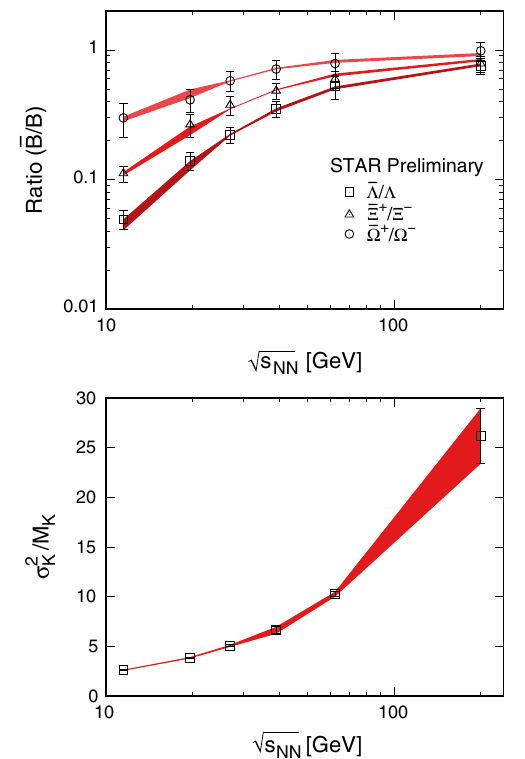
Fig. 1 Upper panel: Ratio ¯ B / B of strange anti-baryon over baryon √ s NN . The yields for (cid:9) , (cid:6) − and (cid:10) − as a function of the beam energy published and preliminary STAR data (symbols) are taken from [17– 19], respectively. The colored bands show the fit results for ¯ B / B within the employed HRG model for the freeze-out conditions determined in this work. Lower panel: Lowest-order net-kaon fluctuation measure √ σ 2 / M σ 2 s NN . The over mean M K as function of K of variance K K published STAR data (squares) are taken from [15], where the shown error bars indicate only the dominating systematic error. The colored band depicts our fit results for the freeze-out conditions shown in Fig. 2